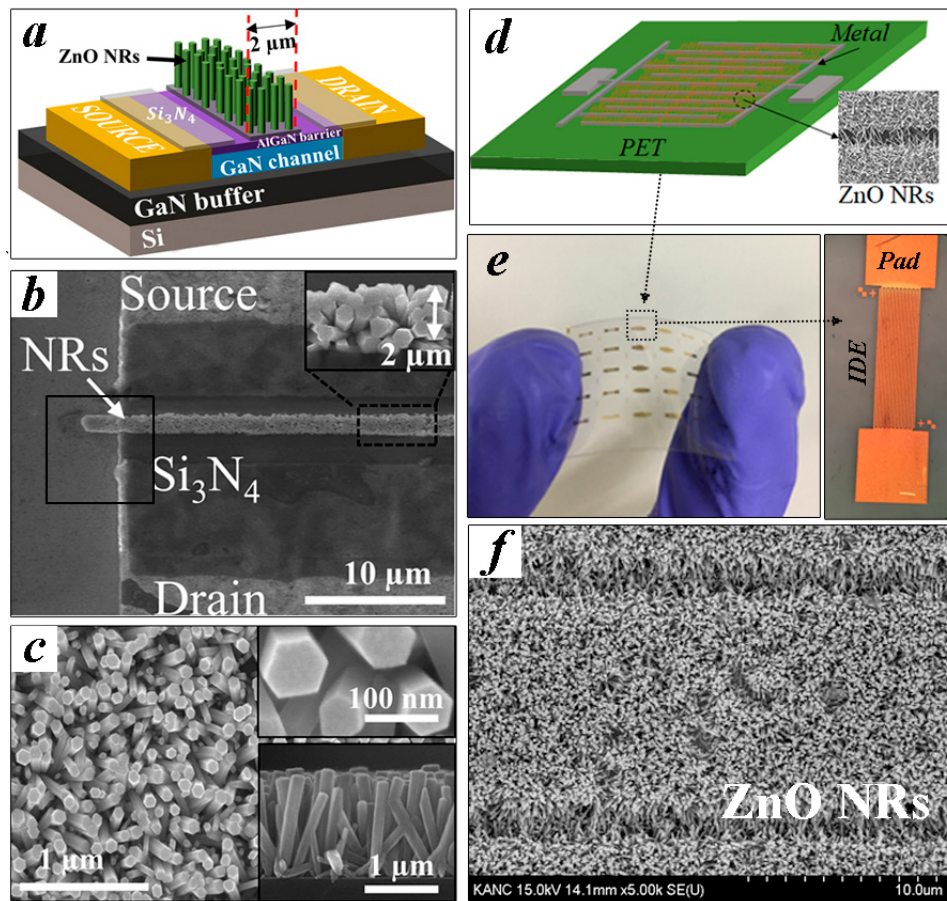
Figure 1. ( a ) Schematic illustration and ( b ) planar-view SEM micrograph of the fabricated ZnO NR-gated AlGaN/GaN HEMT. ( c ) Planar-view, (top-right inset) expanded top-view, and (bottom-right inset) cross-sectional SEM views of as-grown ZnO NRs. ( d ) Schematic illustration of IDE pattern-based UV PD fabricated on the PET substrate. ( e ) Fabricated IDE pattern-based UV PD (right inset: an expanded view of PD) with ( f ) a SEM micrograph showing the grown NR array on a metal pattern.